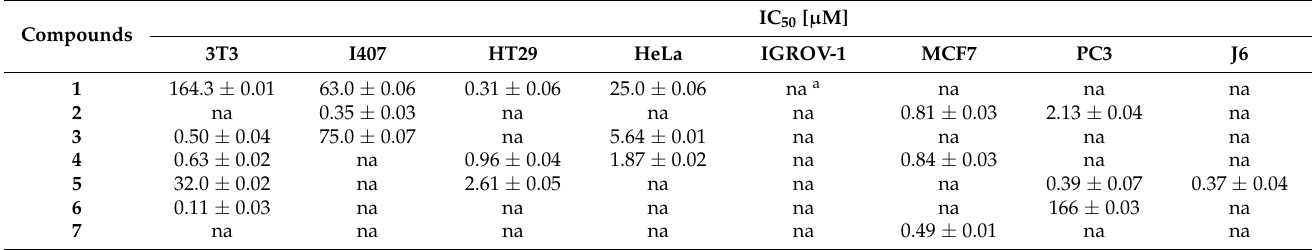
Table 2. In vitro cytotoxic activity of new compounds tested on two normal and six cancer cell lines, expressed as IC 50 [ µ M] a